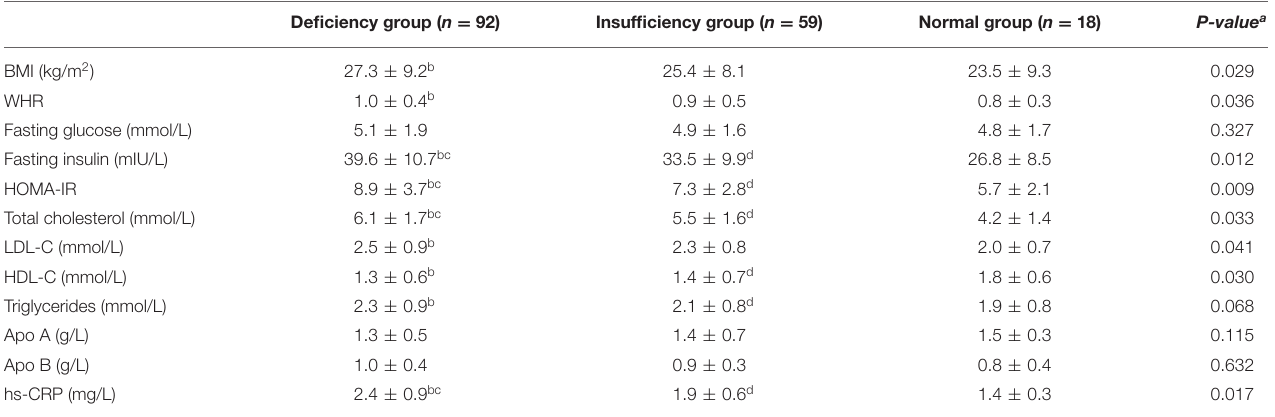
TABLE 2 | Metabolic parameters among different vitamin D status in women with PCOS. Deficiency group ( n = 92) Insufficiency group ( n = 59) Normal group ( n =